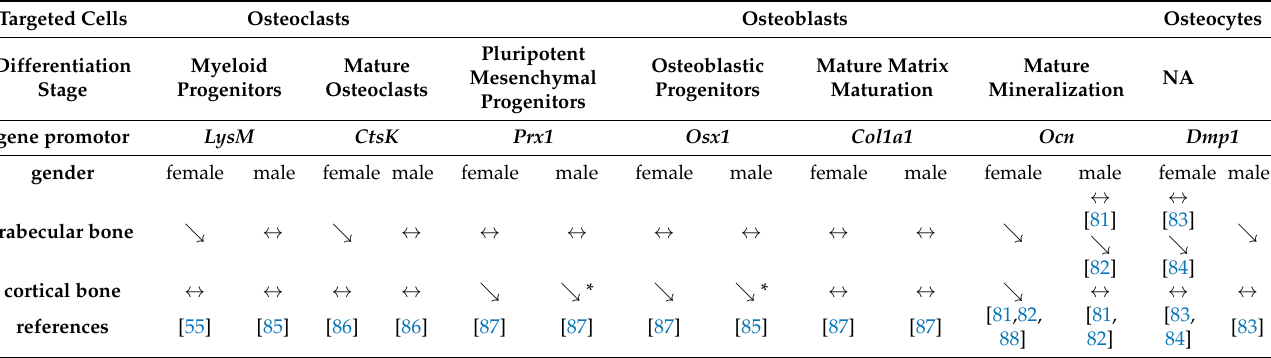
Table 1. ER α role in bone cells and the impact of its selective deletion in trabecular and cortical bone compartments in female and male